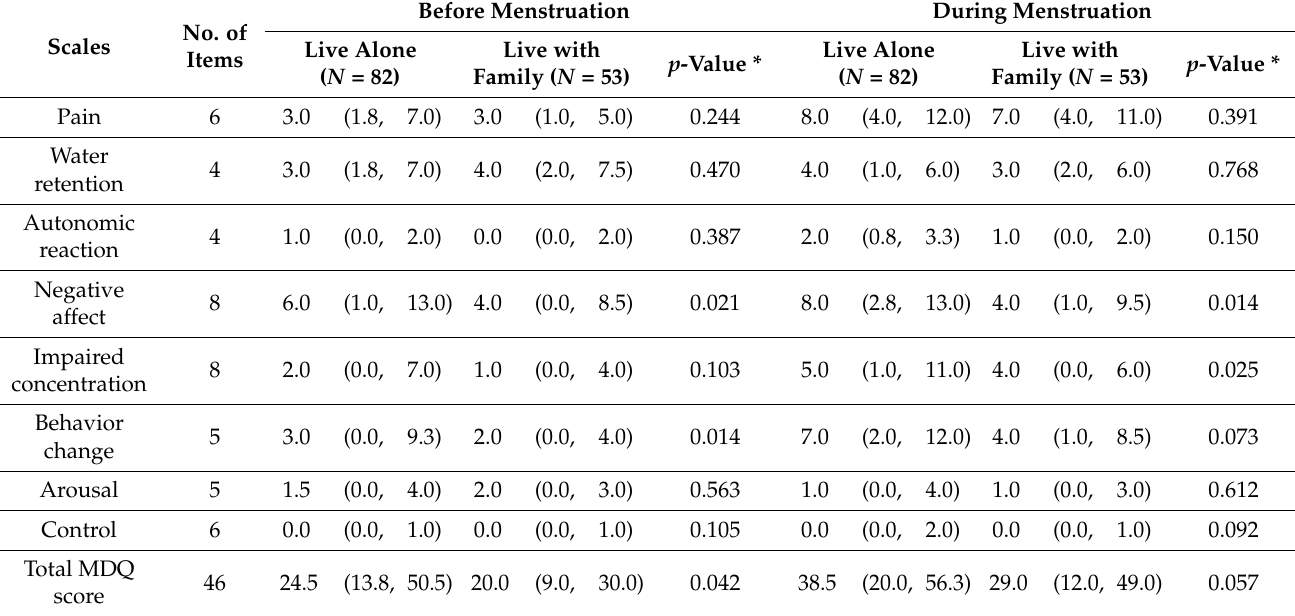
Table 4. Intensities of Menstrual Distress Questionnaire (MDQ) symptoms in scales depending on living status.